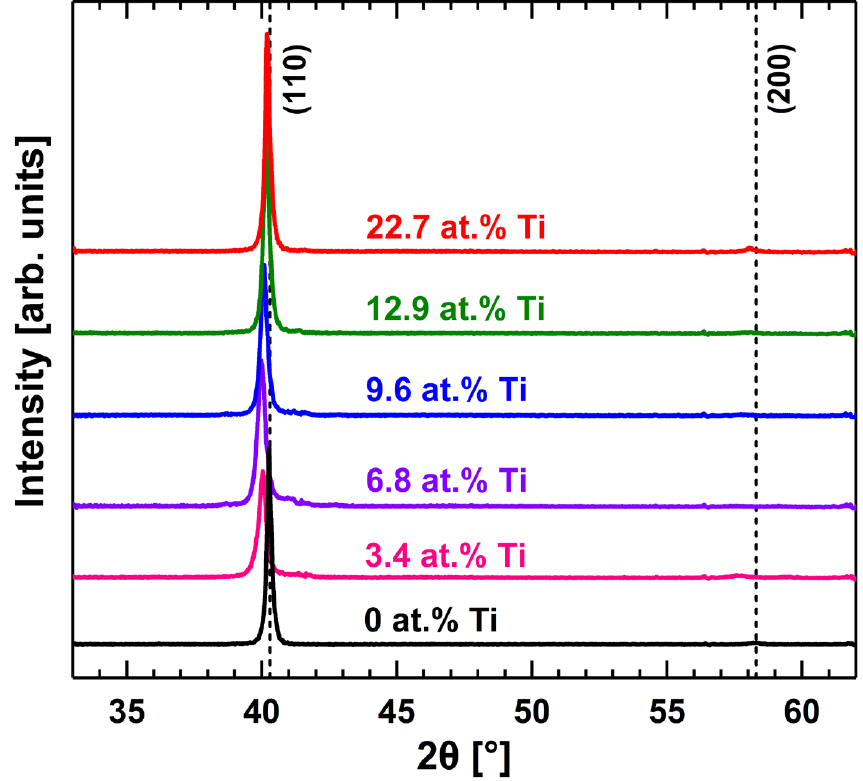
Table 3. Grain sizes of the WTi films with respect to the Ti content.